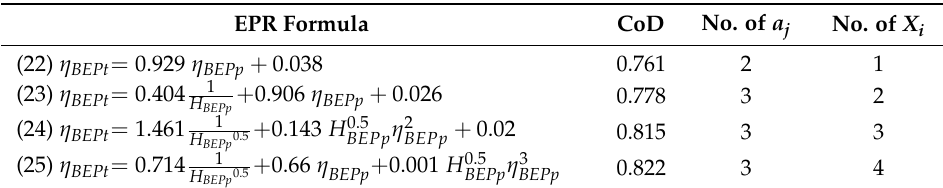
Table 13. Models returned by EPR-MOGA for η BEPt